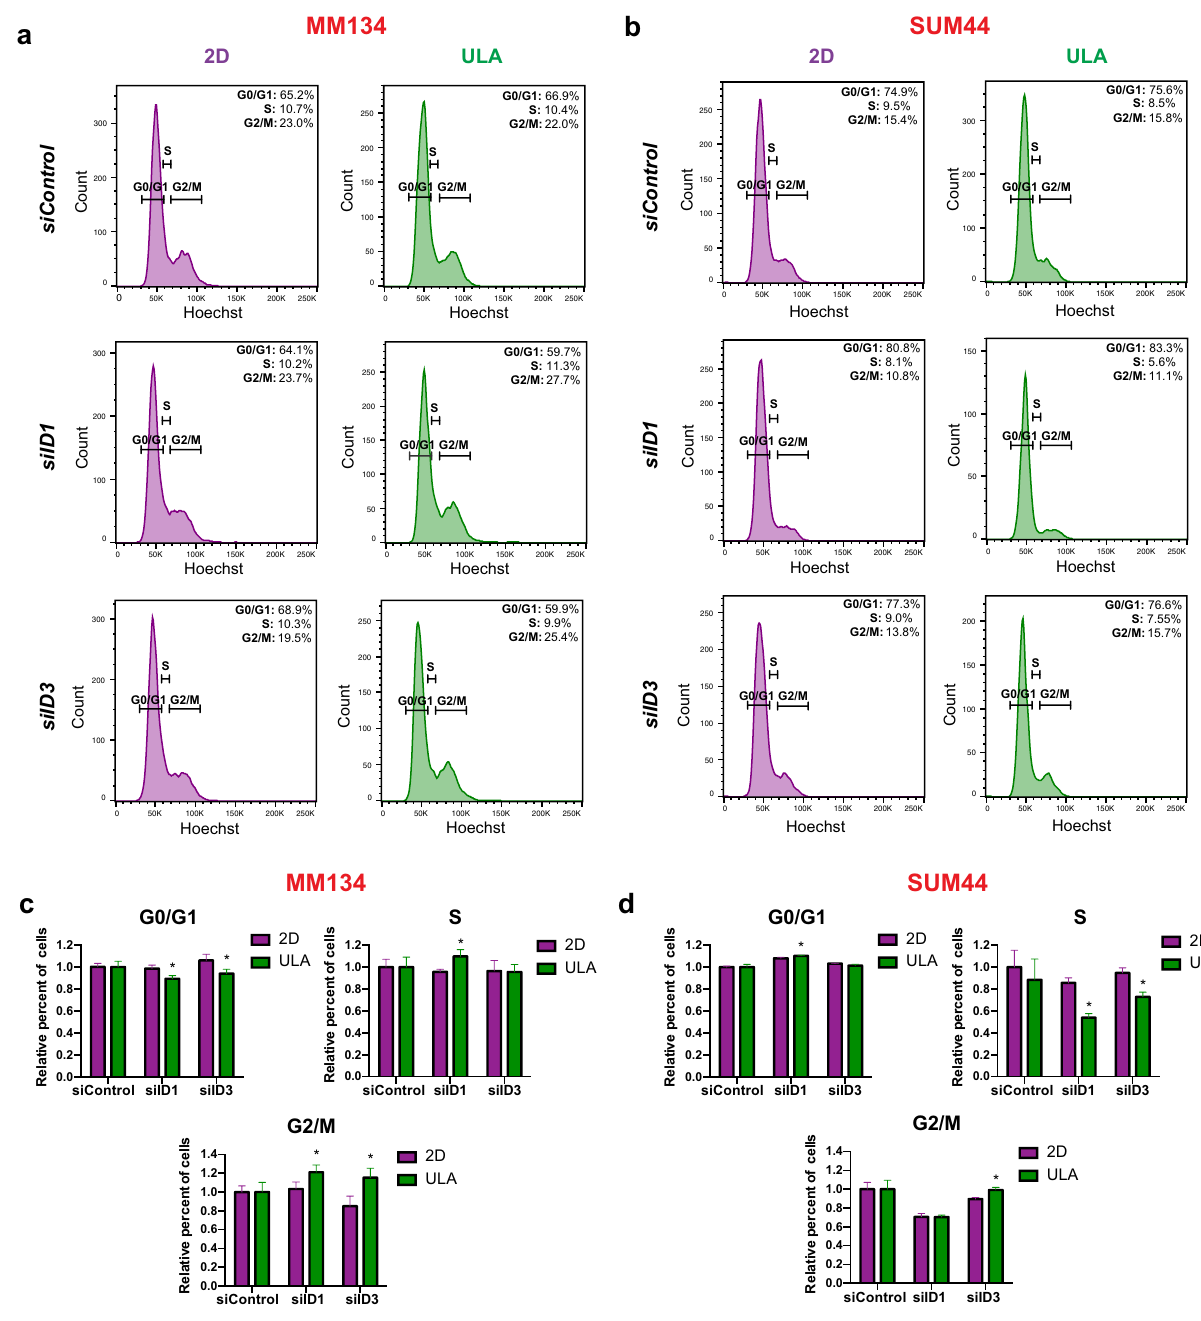
Figure 6. Cell cycle analysis in ILC cell lines with ID1 or ID3 knockdown in 2D and ULA culture. ( a , b ) Representative FACS plots from Hoechst staining of the ILC cell lines ( a ) MM134 and ( b ) SUM44 6 days after transient transfection with the indicated siRNAs in 2D (left; purple) or ULA (right; green) culture. ( c , d ) Quantification of the cells in the indicated phases of the cell cycle based on the gating in ( a , b ) in ( c ) MM134 and ( d ) SUM44 ILC cell lines. Data is displayed as mean percent of cells ± standard deviation relative to siControl in each condition in each cell line (n = 3). p-values are from t tests between 2D and ULA for each siRNA. *p ≤